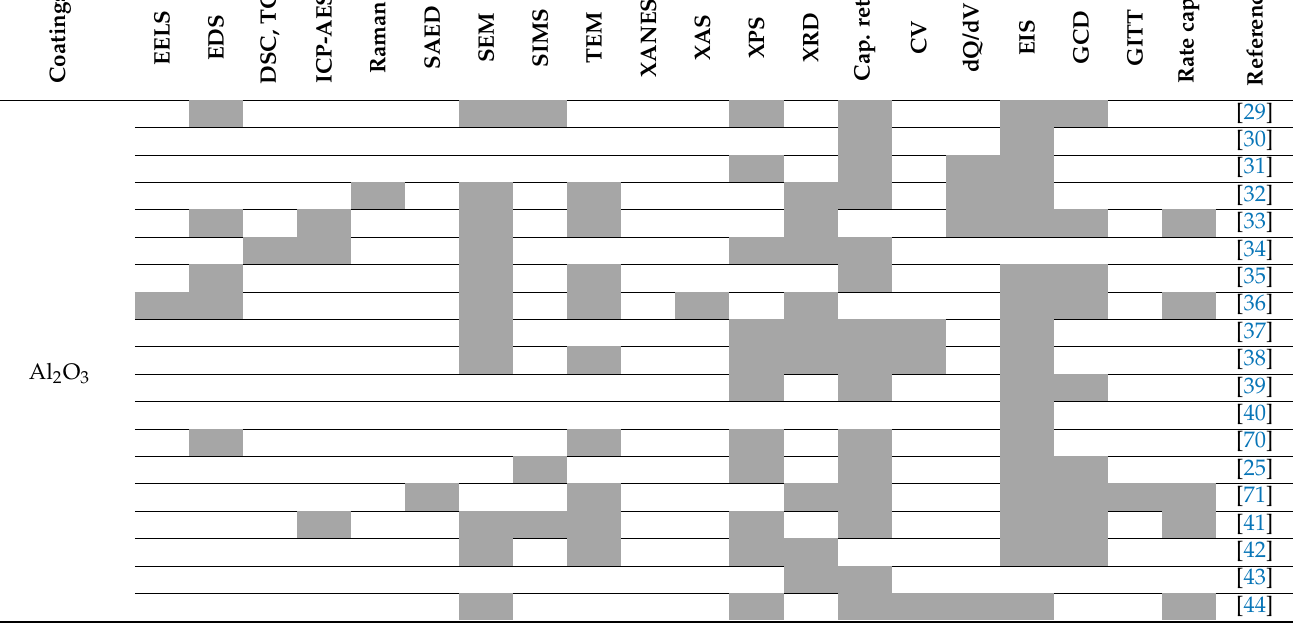
Table A1. List of the main studies in the field of cathode modification by the ALD method. D